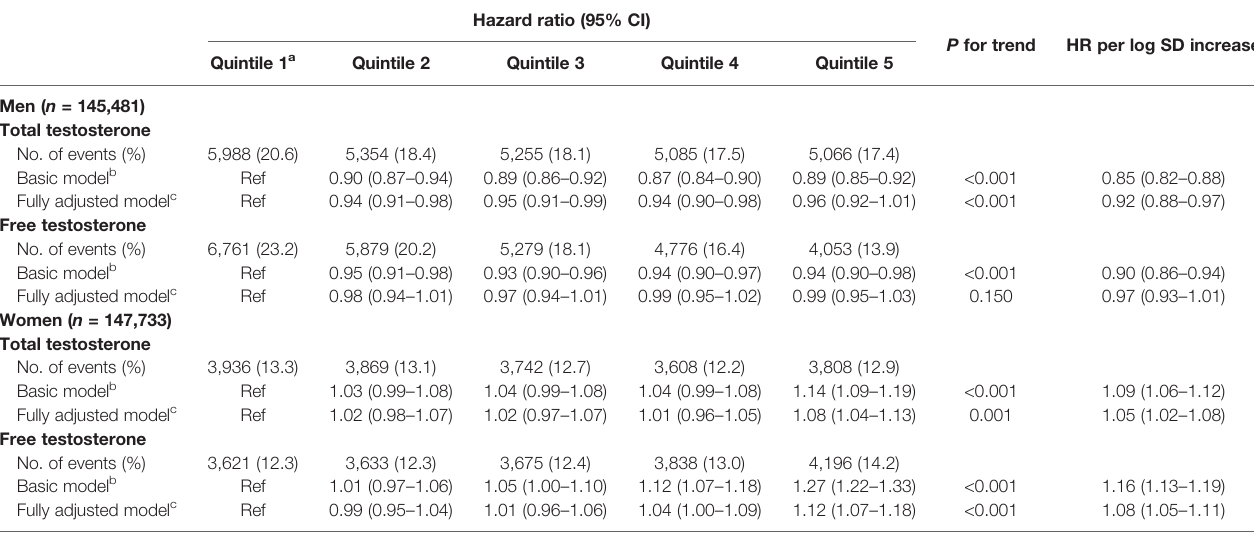
TABLE 2 | Associations of total testosterone and free testosterone with risk of health span termination in both